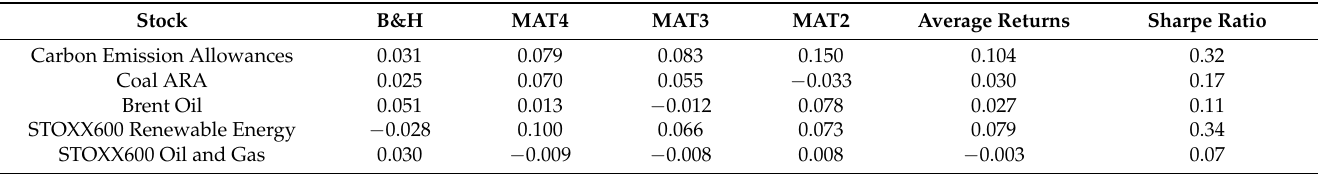
Table A5. Annualized daily (every third month) returns of MAT2–MAT4 (T = every third month, and 4, 3, 2, are the numbers of observations in the rolling window), average returns and Sharpe ratios.